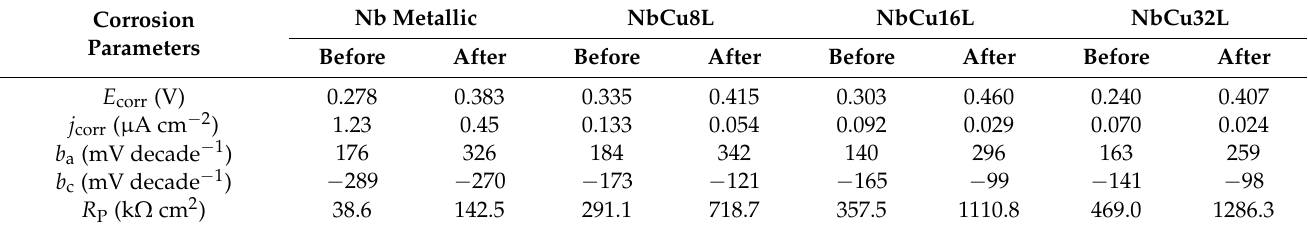
Table 3. Corrosion parameters of metallic Nb and Nb coatings on Cu in 0.05 M H 2 SO 4 + 0.1 ppm F − (pH = 1.4) before and after polarization at 2 V for 6